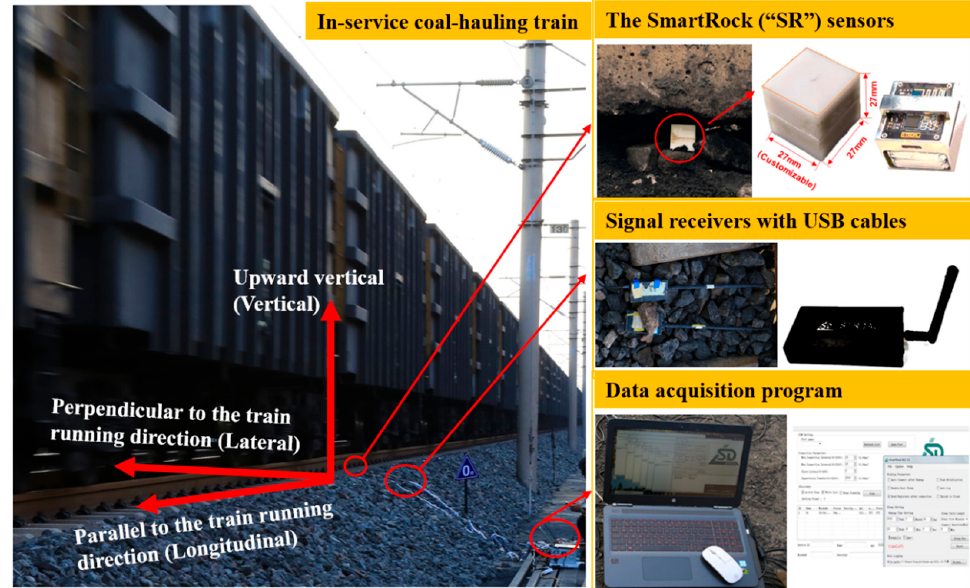
Figure 3. The SR sensors instrumented in the ballast bed of the railway section studied and key components of the corresponding data acquisition system.